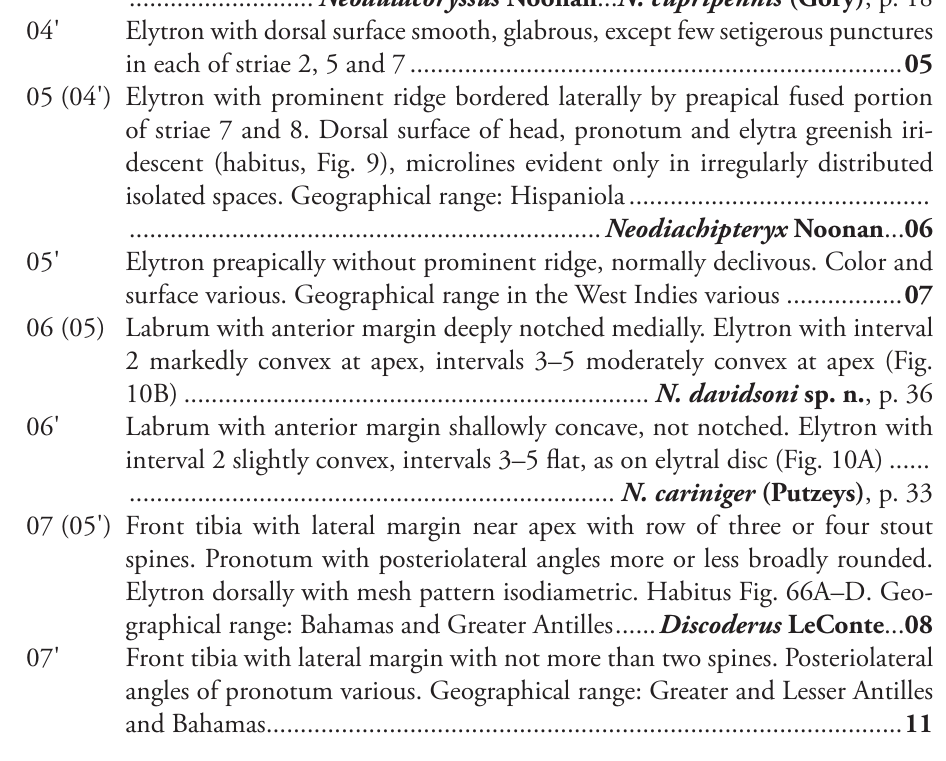
03 (01') Elytron with dorsal surface densely punctate, each puncture round, with seta shorter than those of striae 2, 5 and 7. Habitus, Fig. 1C. Geographical range: 03' Elytron with dorsal surface impunctate (except the standard setigerous punc- tures in striae 2, 5 and 7), or intervals catenate, with elongate punctures. Geographical range in West Indies various ................................................ 04 04 (03') Elytron with dorsal surface with interconnected chains of punctures. Dorsal surface generally coppery (habitus, Fig. 1A). Geographical range: Lesser An-